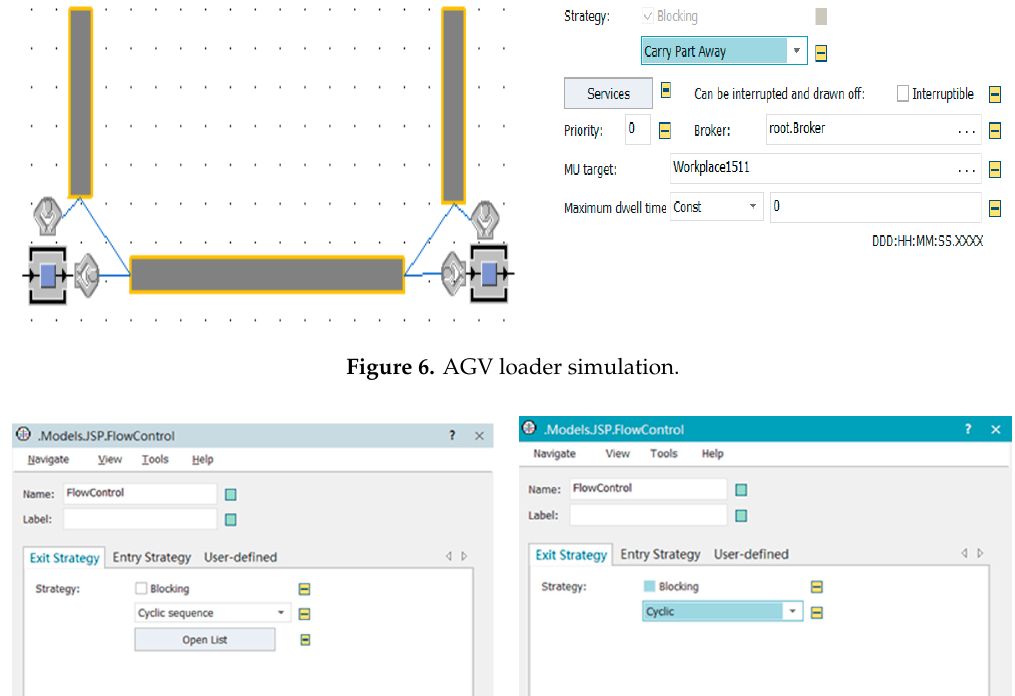
Figure 7. ( a ) and ( b ) show the evenly distributed batch simulation implementation. Figure 7. ( a , b ) show the evenly distributed batch simulation